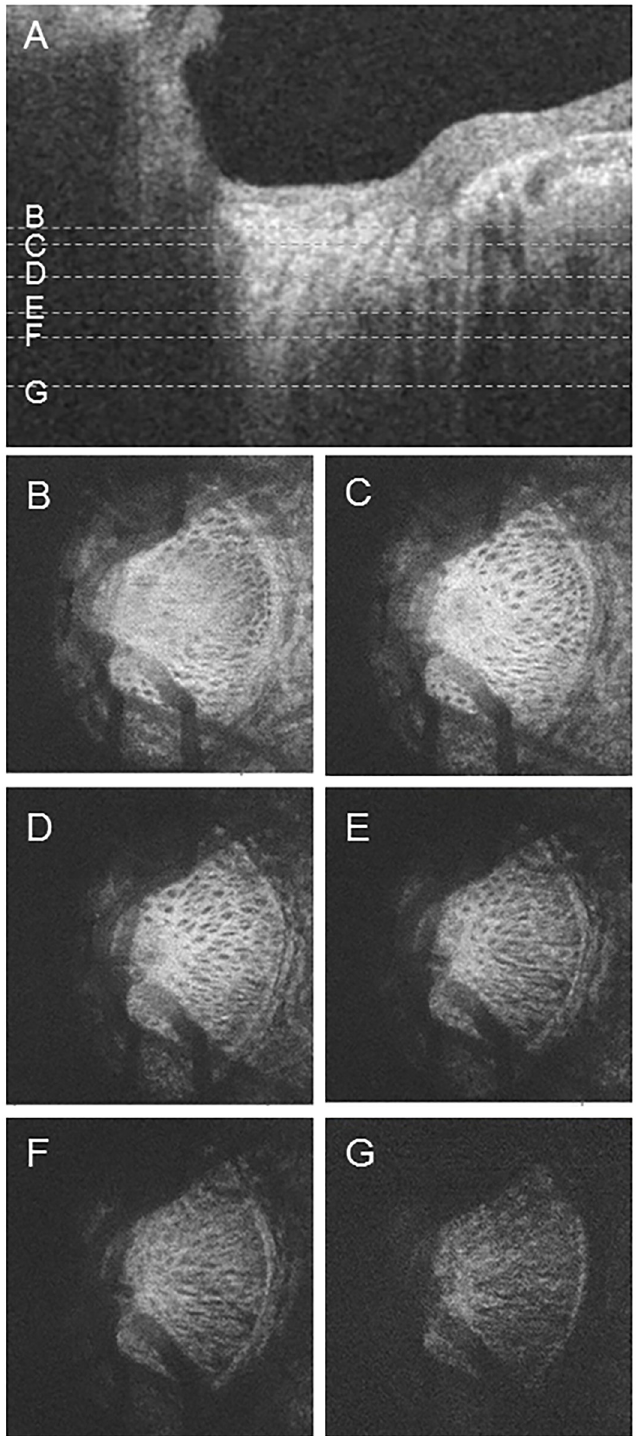
Fig 3. B-scan and en-face images. (A) B-scan image. The dotted lines (B-G) indicate the position of the en- face images below. (B) Upper area of the lamina cribrosa (LC). (C) Upper border of the LC. (D, E) Centerline of the LC. (F) Lower border of the LC. (G) Lower area of the